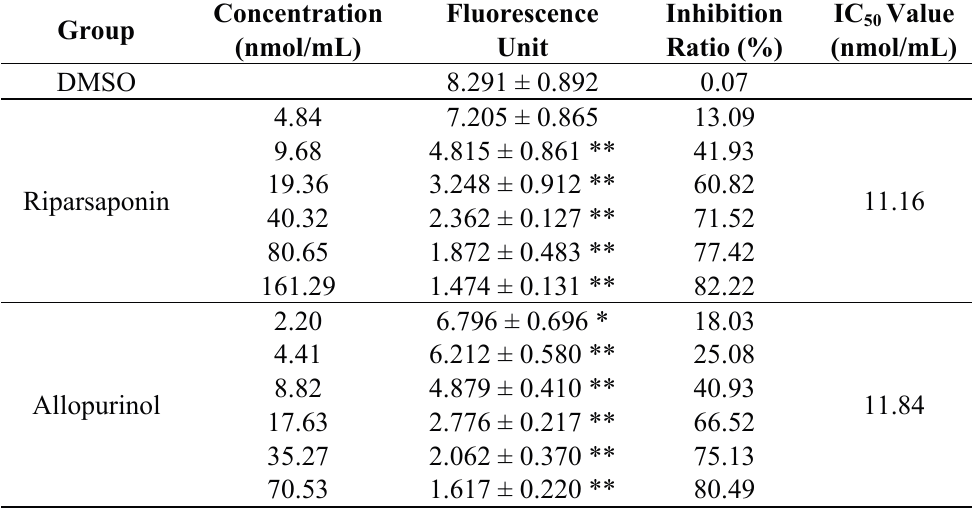
Table 3. Inhibitory effect of riparsaponin on xanthine oxidase activity (n =